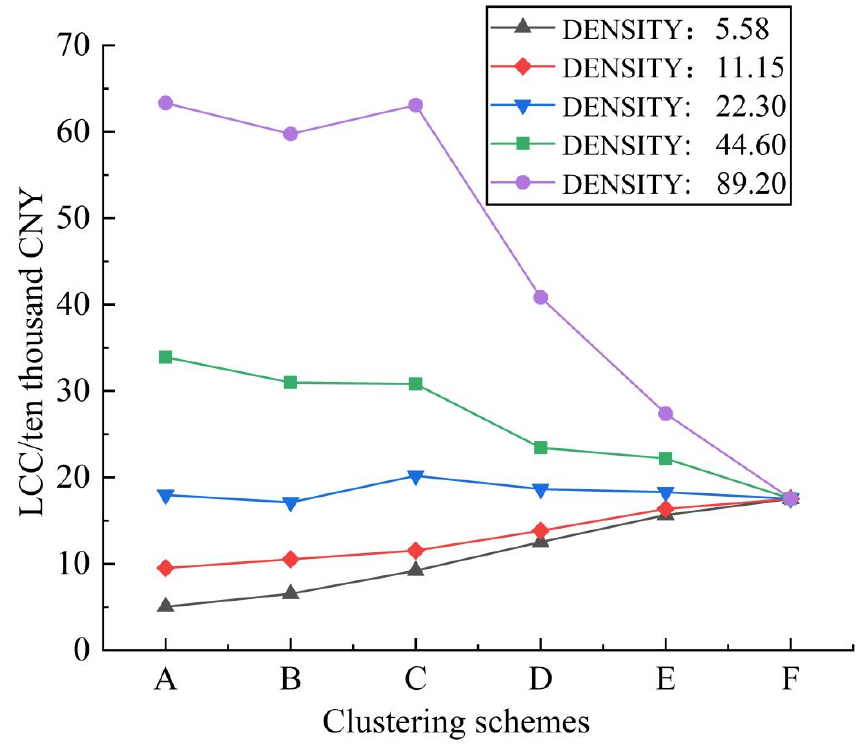
Figure 10. Variation of LCC with different clustering schemes when building density changes.